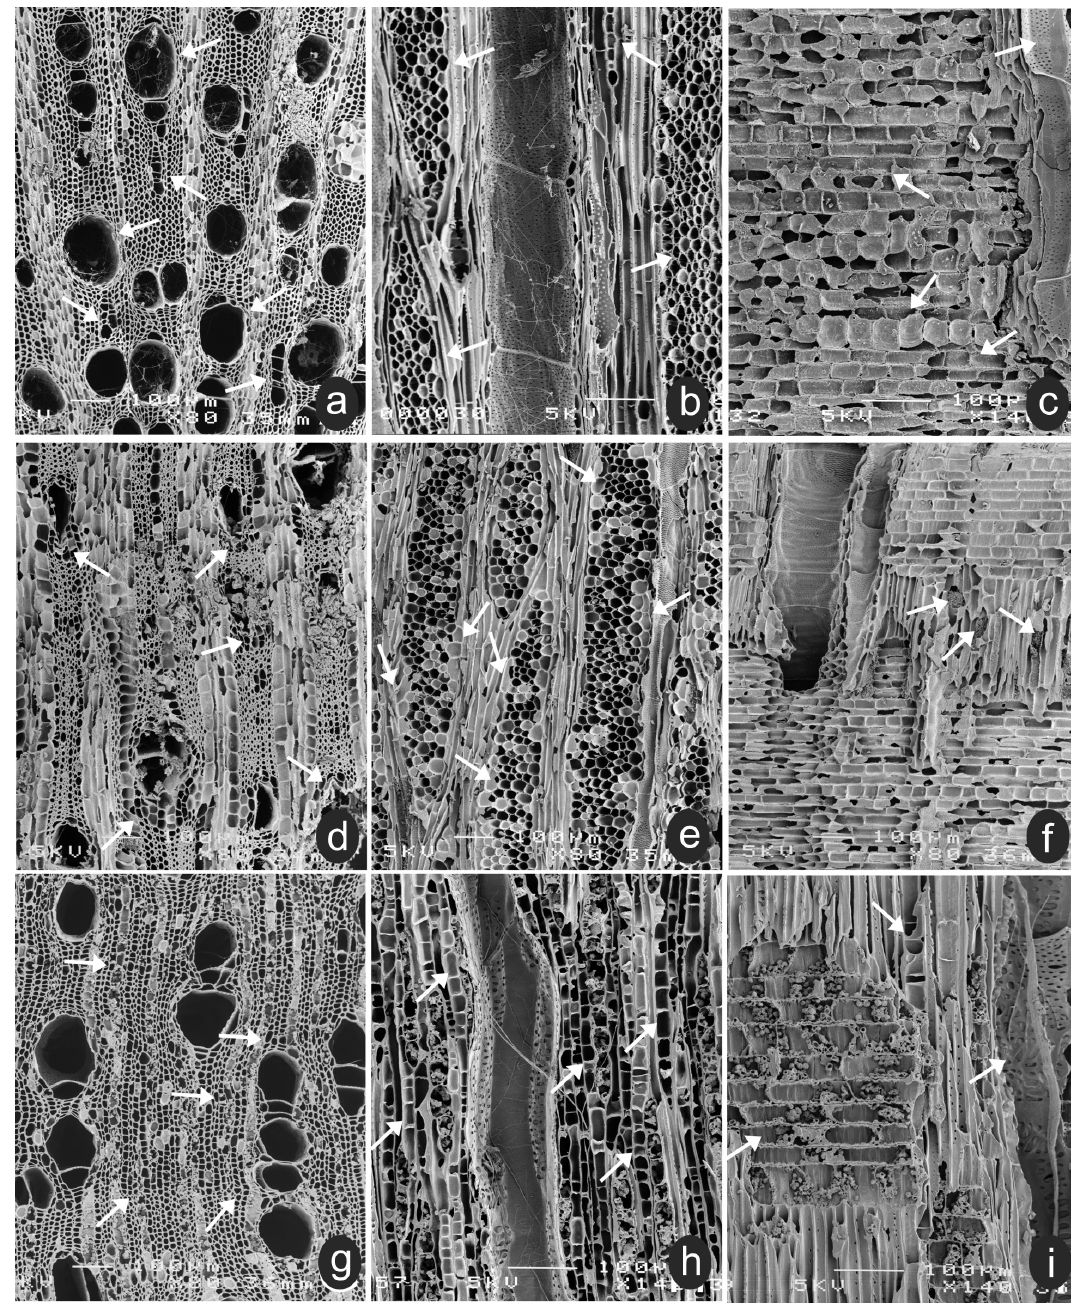
Figure 1. a-b-c. Anemopaegma prostratum DC. (Bignoniaceae / SPw731) [Arrows: a- vessels of two distinct diameter classes, wood not ring-porous; b- rays of two distinct sizes (uni and multiseriate); c- vessel-ray pits similar to intervessel pits (up left) and procumbent and square cells mixed in a multiseriate ray]. d-e-f. Cordia ecalyculata Vell. (Boraginaceae / BCTw3799) [Arrows: d- axial parenchyma; e- sheath cells; f- crystal sand]. g-hi Kielmeyera coriacea Mart. & Zucc. (Calophyllaceae / BCTw 15140) [Arrows: g- growth rings (inclined lower arrows) and axial parenchyma (horizontal arrows); h- uniseriate rays; i procumbent and square cells mixed in the ray (left arrow); axial parenchyma cells (middle arrow); vessel-ray pits larger than intervessel pits (right arrow)]. a-d-g: Transverse section. – b-e-h: Tangential section. – c-f-i Radial section. Bars = 100